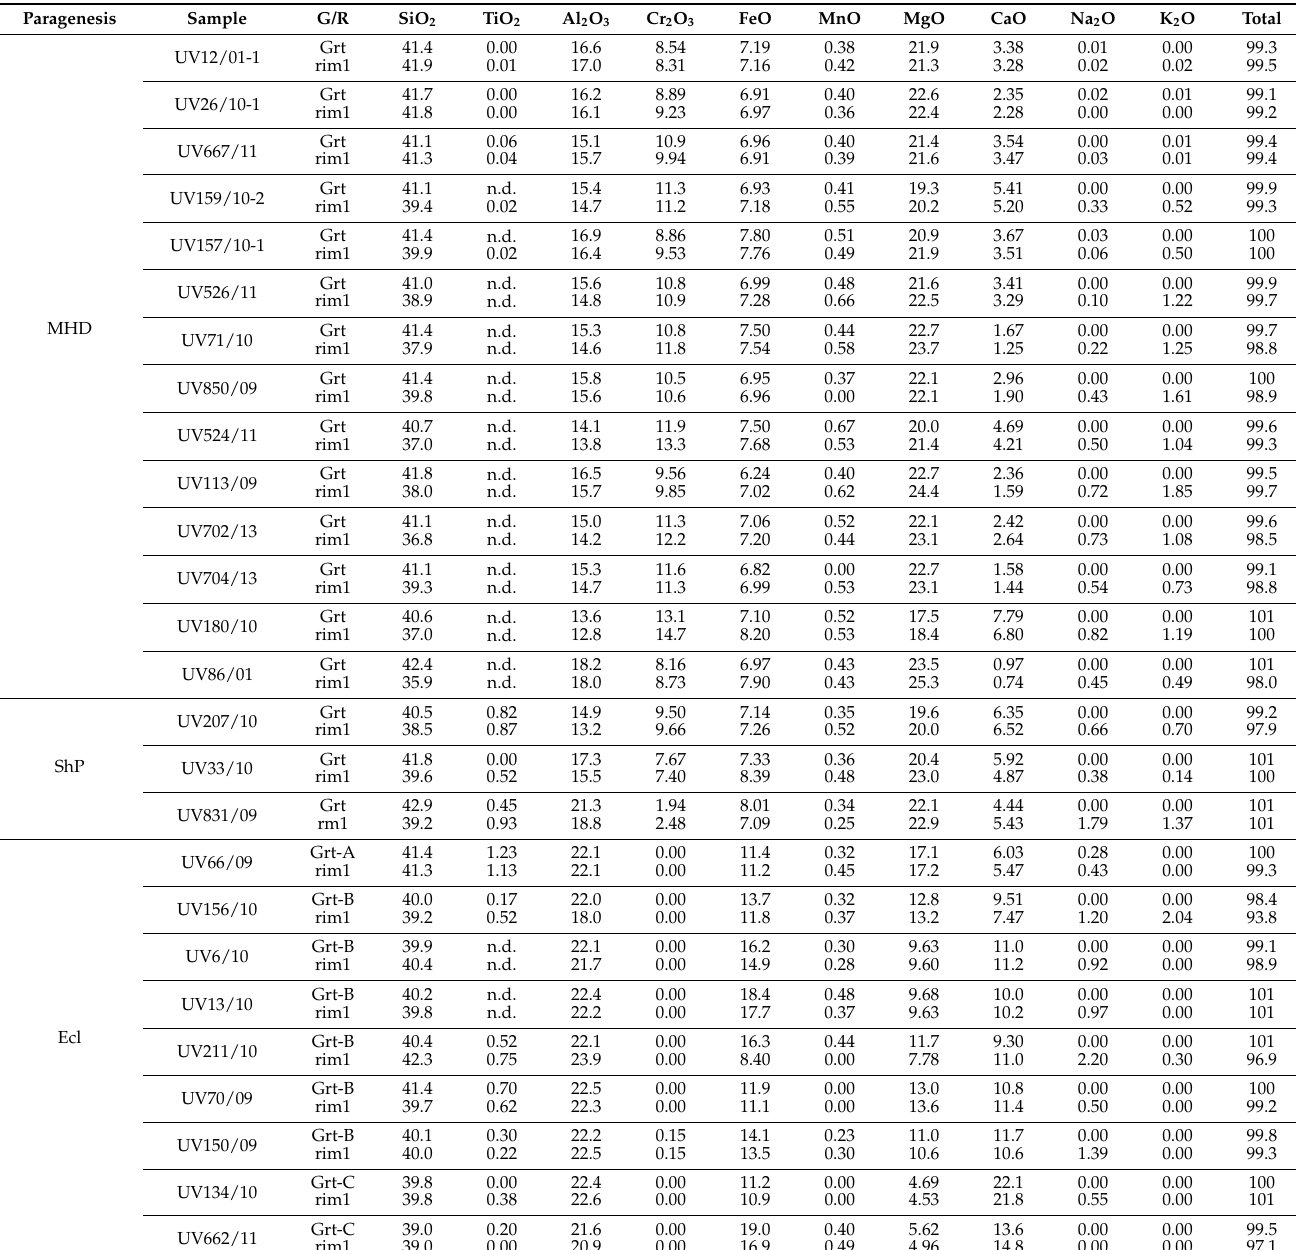
Table 3. Chemical composition (wt.%) of garnet and bulk composition of kelyphite rim.